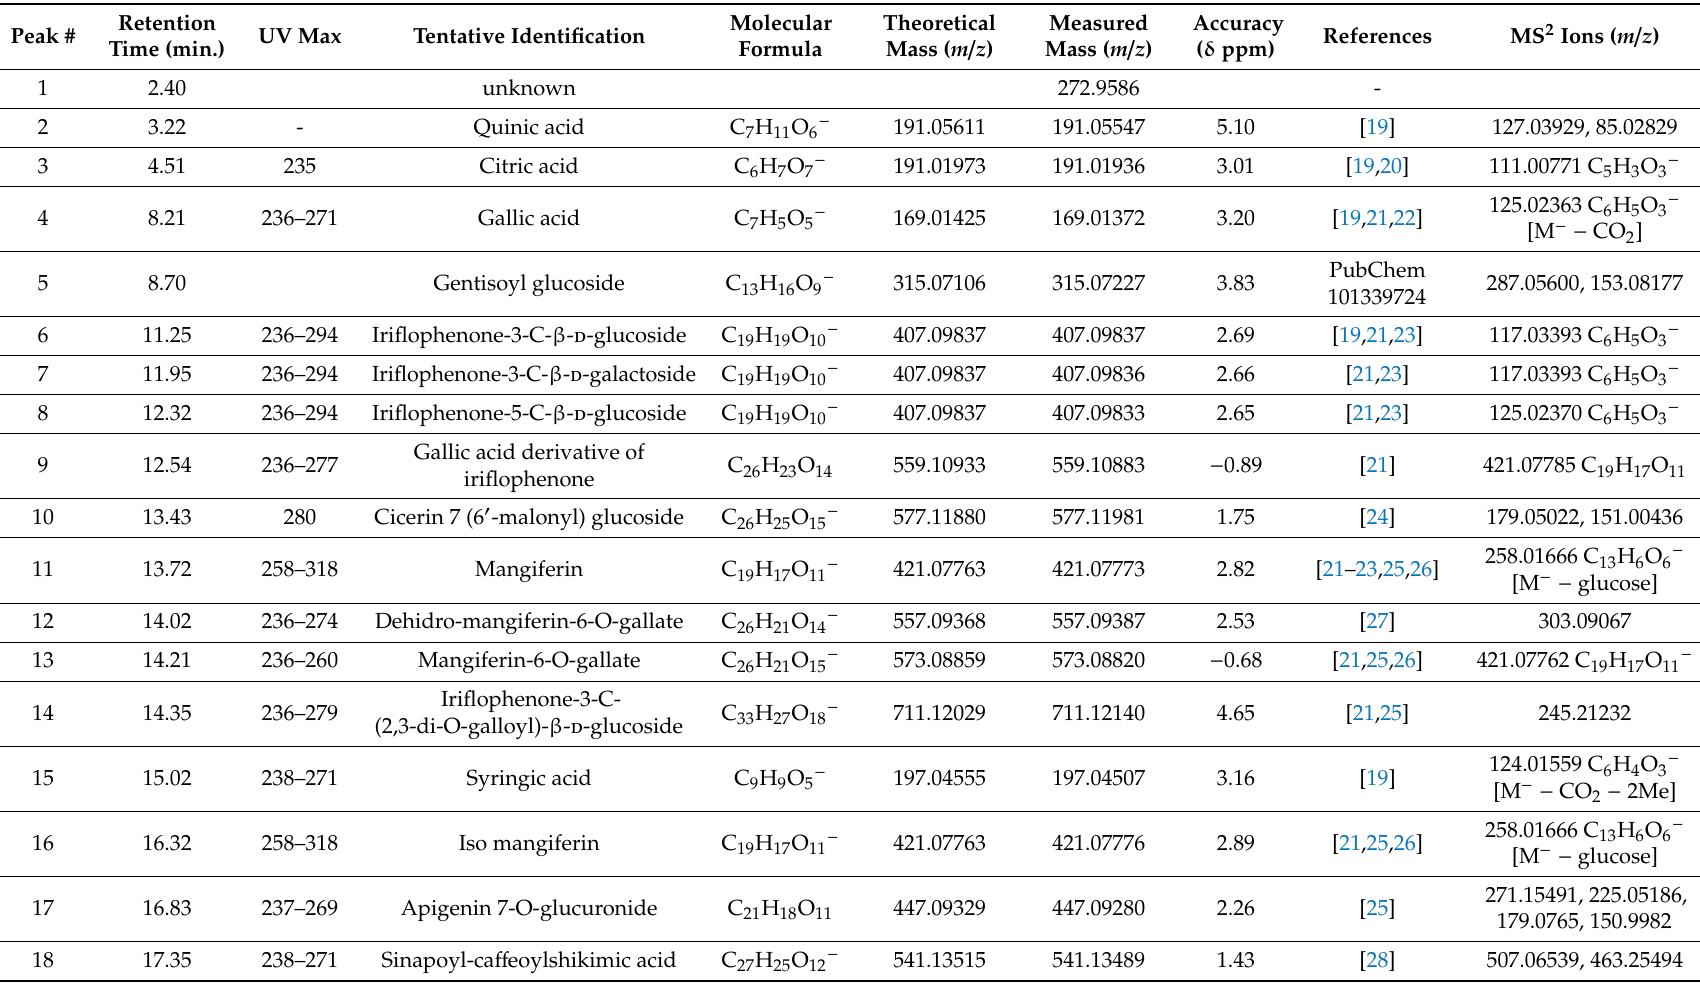
Table 1. High resolution UHPLC-Photodiode Array Quadrupole Orbitrap (PDA-Q-OT) identification of metabolites in